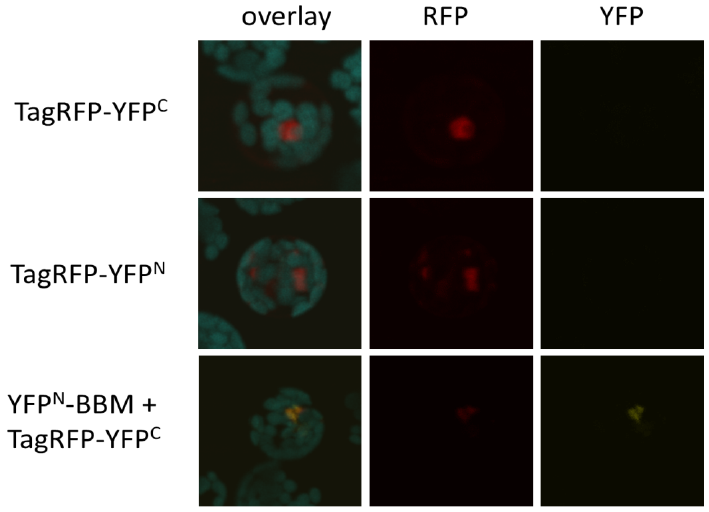
Figure 5. Self-assembly of YFP fragments. Confocal images of Arabidopsis protoplasts eight hours after transfection with either single TagRFP-YFP C or -YFP N plasmids, or with TagRFP-YFP C and YFP N -BBM plasmid combinations. The first column shows an overlay image of the background autofluorescence signal ( blue ), the TagRFP signal ( red ) and the YFP signal ( yellow ). The second and third columns show only the TagRFP and YFP signals, respectively. Co-transfection of plasmids containing YFP N -BBM and TagRFP-YFP C fragments results in a weak YFP signal, showing the re-constitution of the YFP molecule in the absence of a protein-protein interaction (self-assembly), and indicating the need for suitable negative controls and a quantitative read-out of the fluorescent signal in BiFC